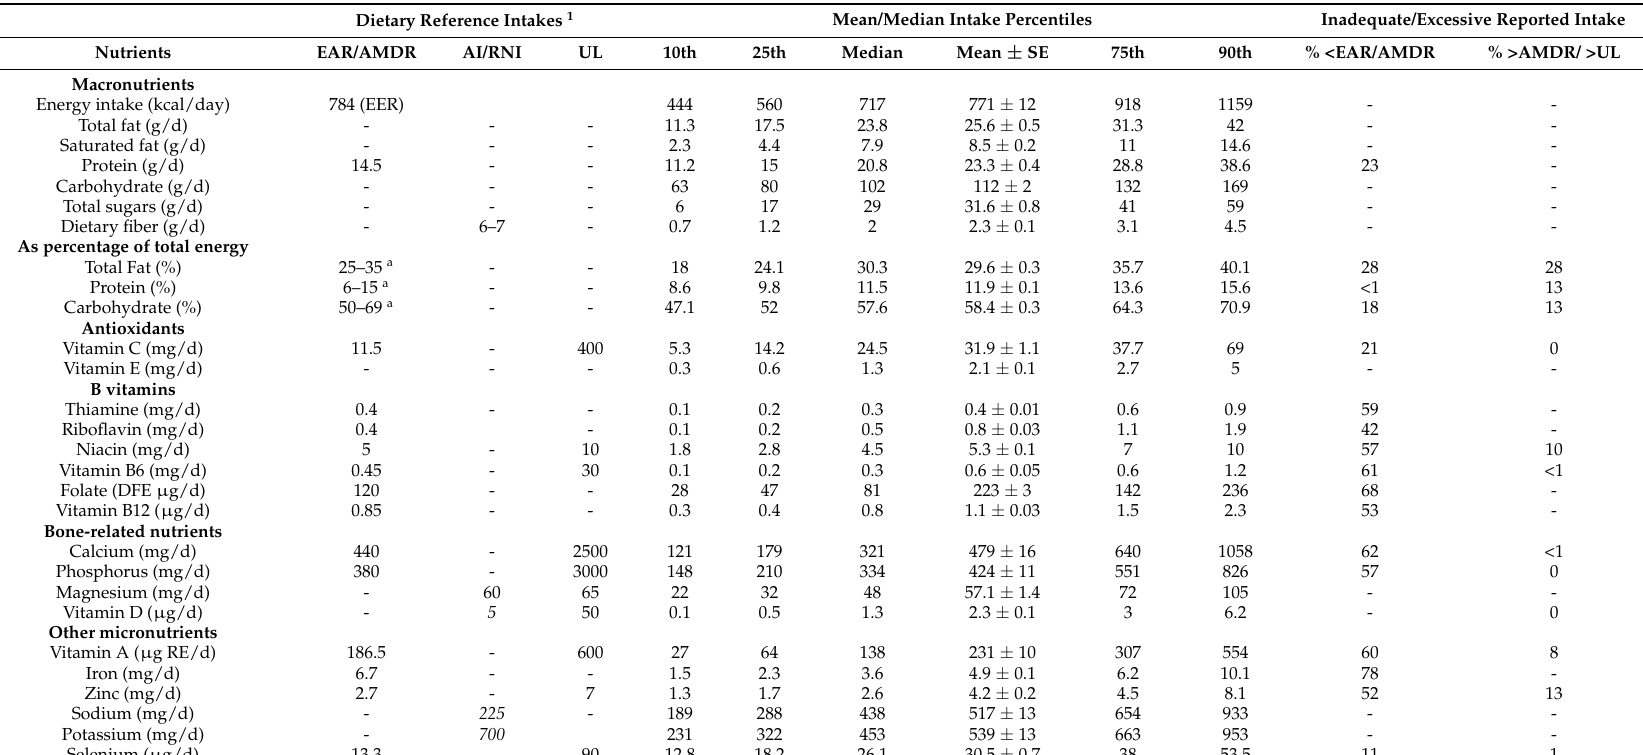
Table 5. Usual energy and nutrient intakes from food and beverages for Filipino toddlers aged 12–23.9 months ( n =